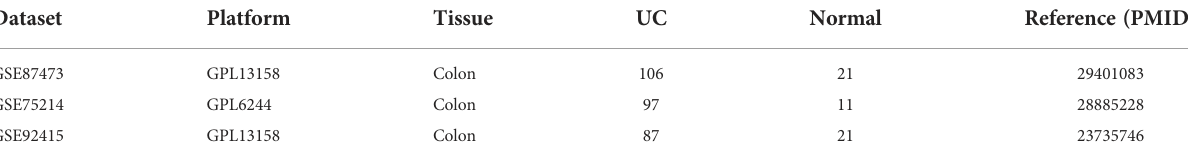
TABLE 1 Details of microarray